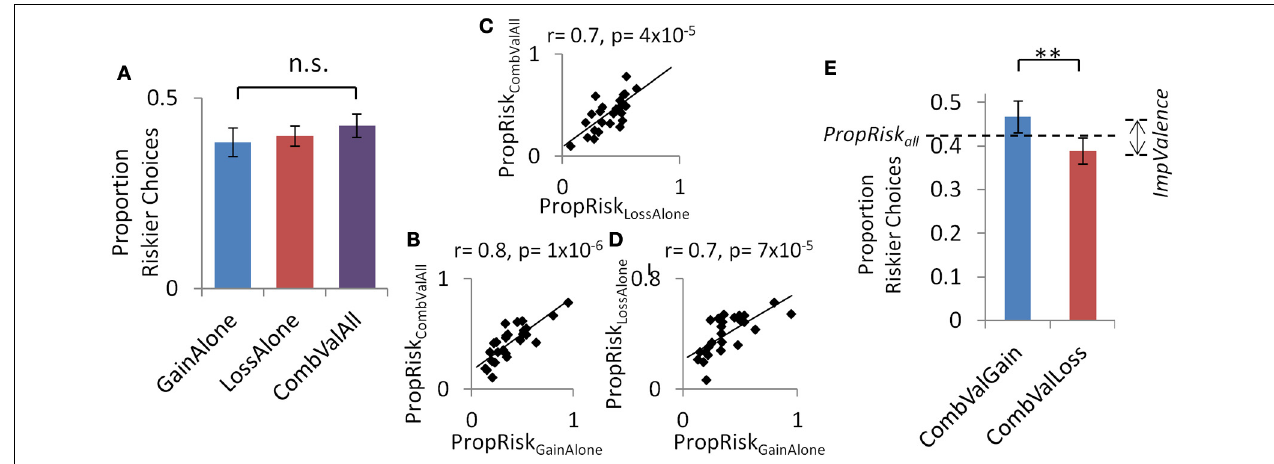
FIGURE 3 | Experiment 2: consistent base-line risk-taking within individuals and additional perturbation by introducing a valence as a dimension in choice. A consistent base-level of risk-taking in the